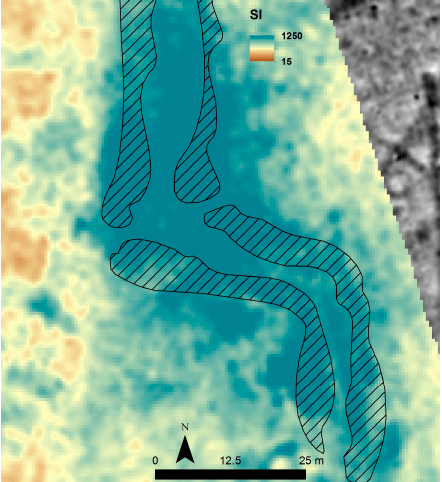
Figure 11. Magnetic susceptibility data from the enclosure in Magoula Almyriotiki suggest a single running feature; unlike the geomagnetic data which reveal a double-ditch like feature.